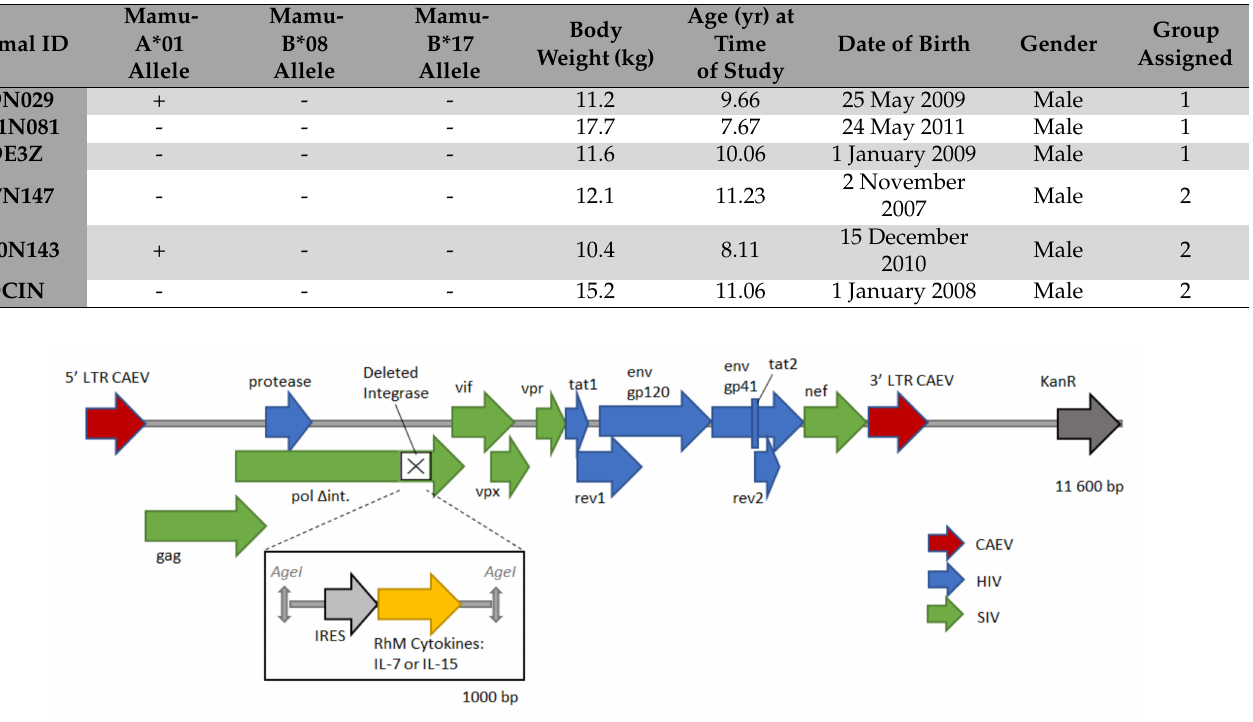
Figure A1. Schematic representation of the CAL-SHIV-IN − IRES cytokine lentiDNA vaccines: CAL- SHIV-IN − was derived from the genome of the chimeric, highly pathogenic SHIV KU2 as previously described [1]. A 1000 bp cassette, containing IRES sequence and rhesus macaque cytokine gene IL-7 or IL-15, was inserted into the integrase-deleted site in CAL-SHIV-IN − genome, ligated by the Age I-restricted extremities.